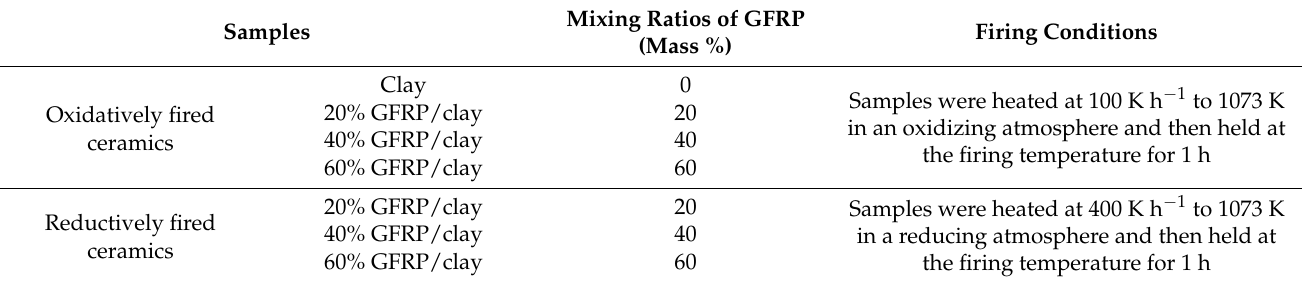
Table 2. Manufacturing conditions for GFRP/clay ceramic